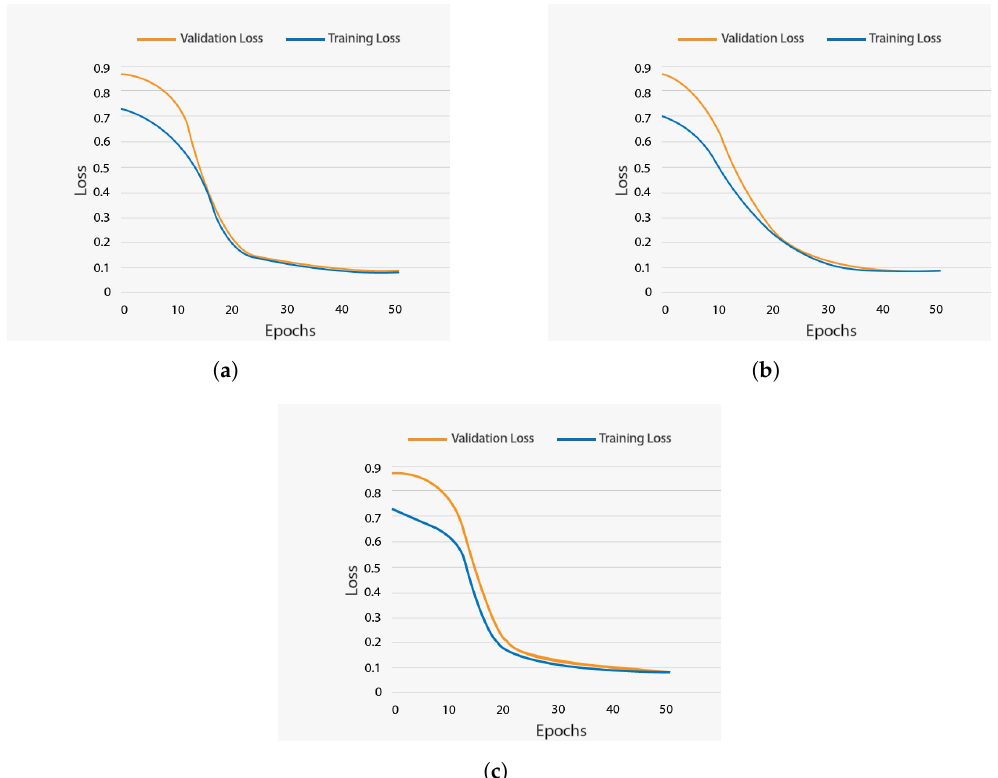
Figure 8. Training and validation loss of various models with the proposed optimization method. ( a ) Training and validation loss of the VGG16 model with the proposed optimization method. ( b ) Training and validation loss of the ResNet model with the proposed optimization method. ( c ) Training and validation loss of the DenseNet model with the proposed optimization